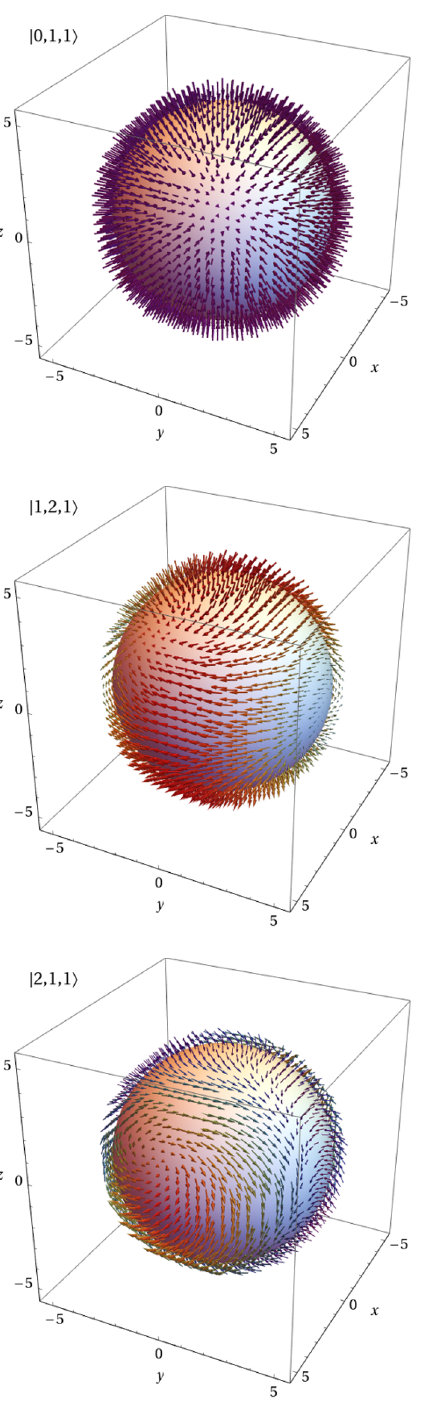
Figure 13 . Real part of the (cid:12)rst few (‘pure-orbital’) vector spherical harmonics Y ‘ three-dimensional real coordinate space ( x = r sin (cid:18) cos ’ , y = r sin (cid:18) sin ’ , z = r cos (cid:18) ).